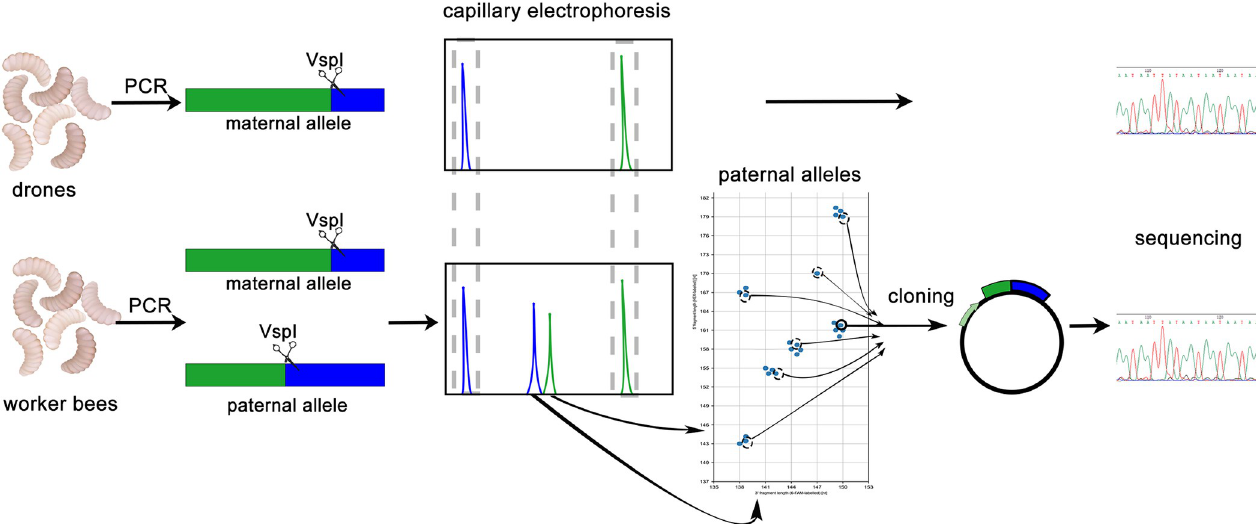
Fig 2. Schematic representation of the methodology of identifying csd genotypes in worker bees.